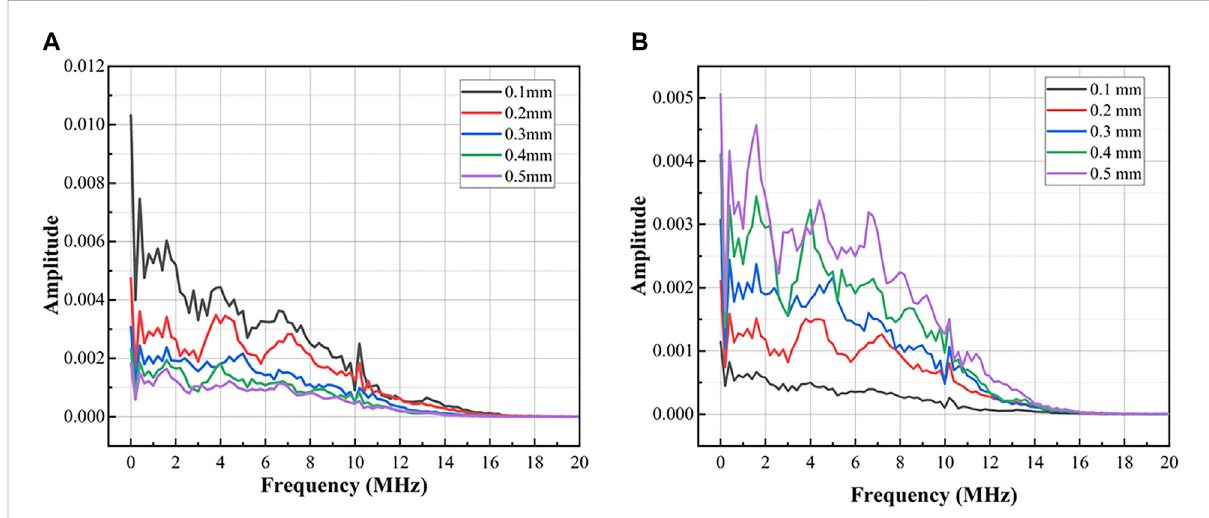
FIGURE 6 Spectrum of different spot radii: (A) Same impulse energy; (B) Same energy density.